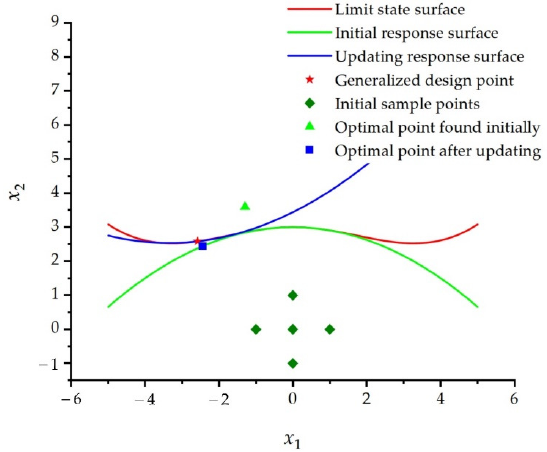
Figure 4. Sketch of the two-dimensional dynamic fitting strategy for the response surface.